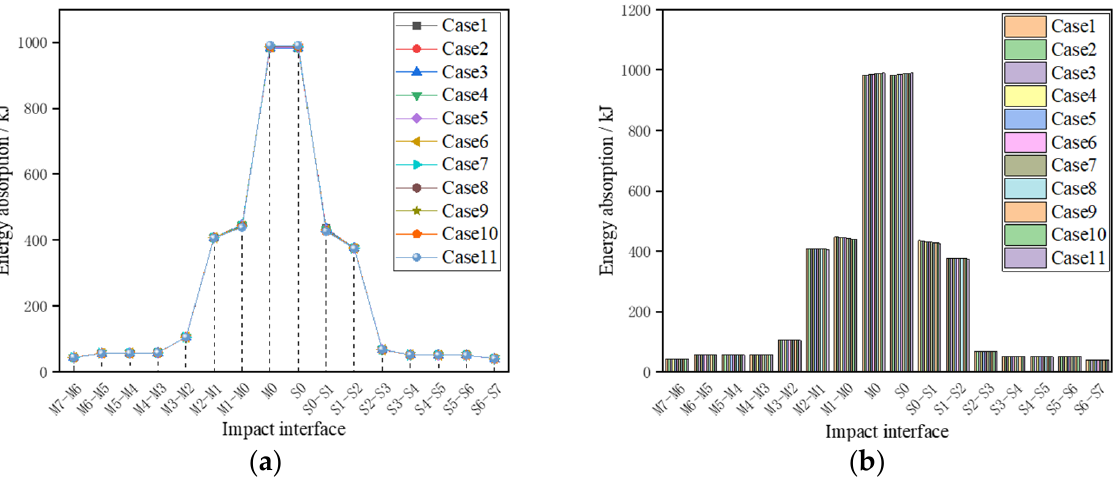
Figure 9. Influence of initial peak force change on overall train collision energy: ( a ) broken line graph, ( b ) bar chart.